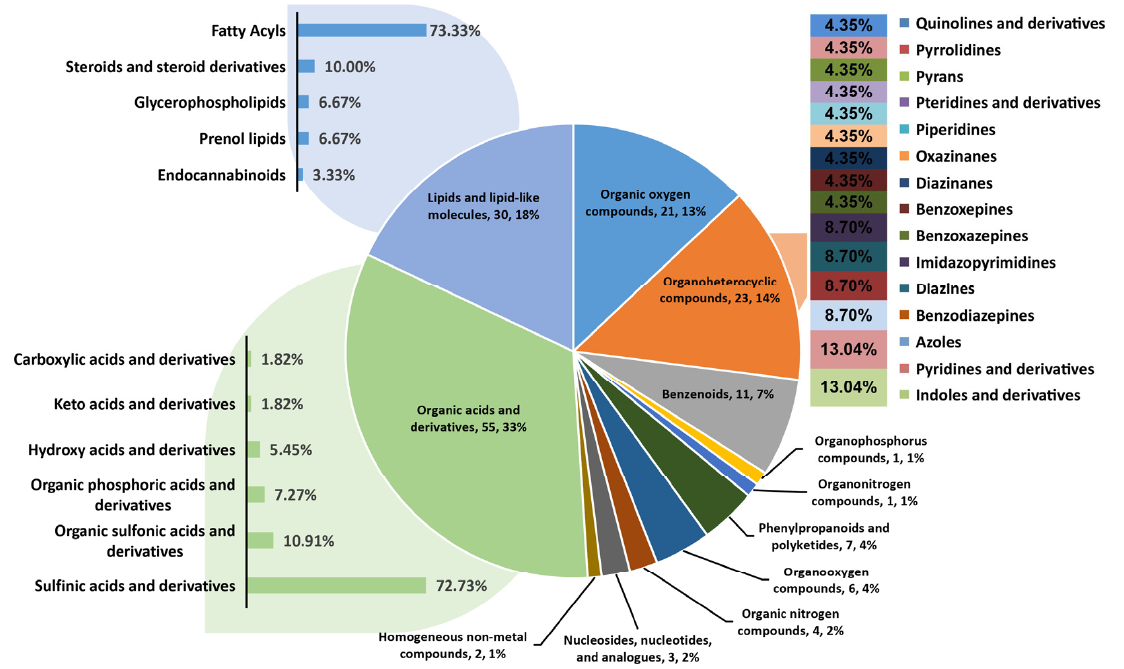
Figure 1. Classification and distribution of five sets of identified metabolites. The distribution of identified metabolites is shown in the pie chart, and subclassifications of amino acids, carbohydrates, and lipids are shown with bar charts and histograms.